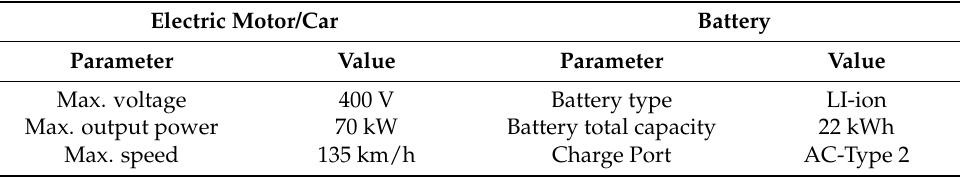
Figure 1. Analyses proposed for this study: ( a ) Carport maintenance and energy generation; ( b ) Renault Fluence ZE DYN energy consumption. Table 1. Electric vehicle technical information [44].